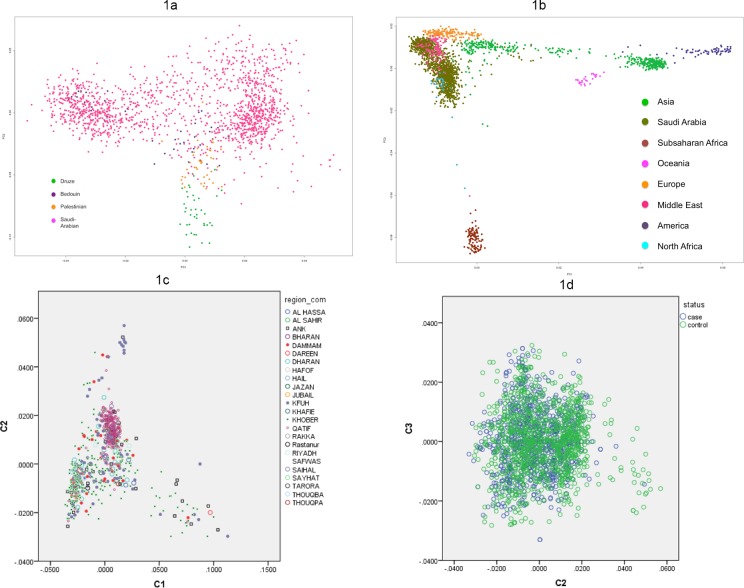
Study subjects (white diamonds) plotted with population reference samples for first (x-axis, PC1) and second (y-axis, PC2) principle components.(A)The clustering with Middle East populations, and (B) with main global populations as sampled in HGDP. (C) Study control subjects plotted according to the KSA province of origin, and (D) all KSA samples according to affection status for the most discriminating principle components.